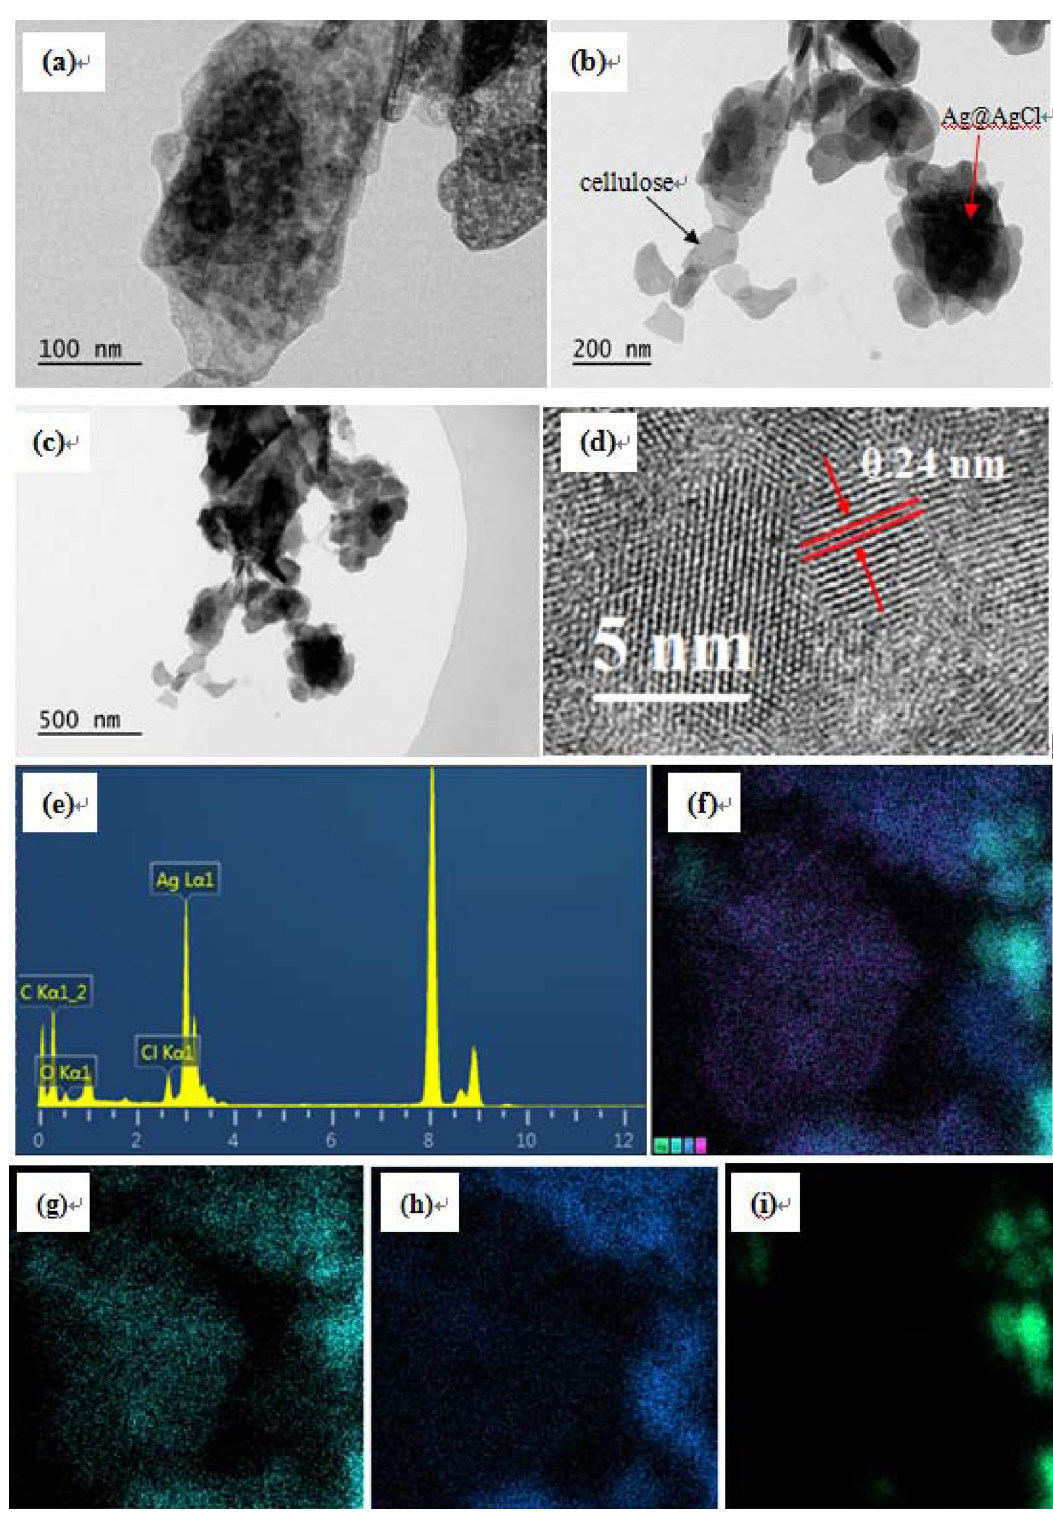
Figure 6. TEM images ( a – c ), HR-TEM image ( d ), the corresponding EDS spectrum ( e ), and mapping analysis of existed all elements ( f ), Cl ( g ), C ( h ), Ag ( i ) of the samples synthesized at 60 °C with 65% (w/w) of ZnCl 2